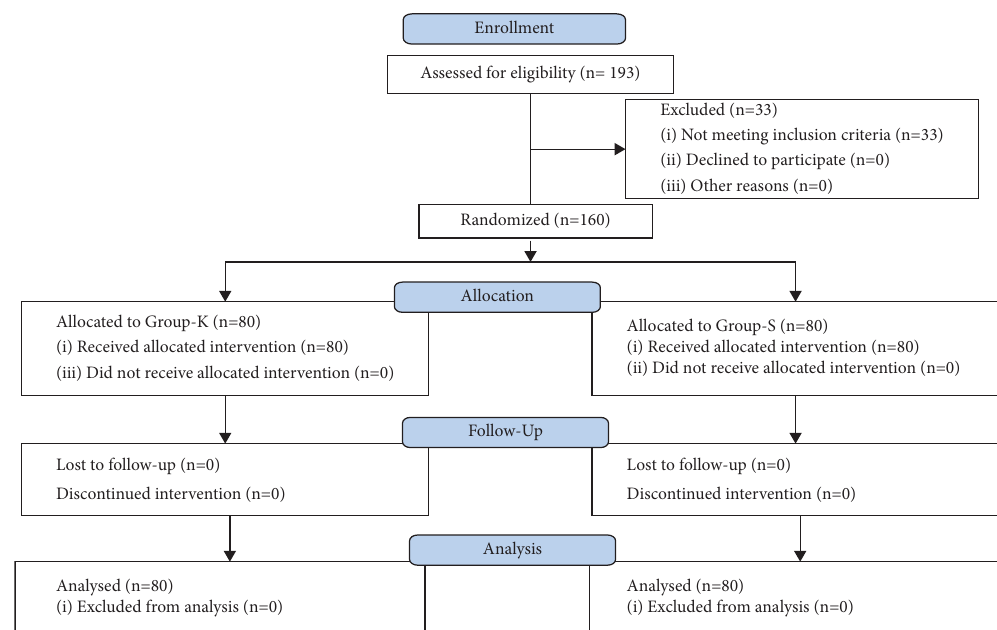
Figure 1: Consort fow